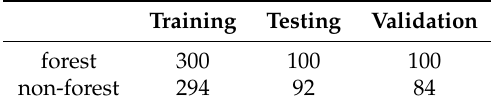
Table 1. Number of source tiles used for the generation of synthetic